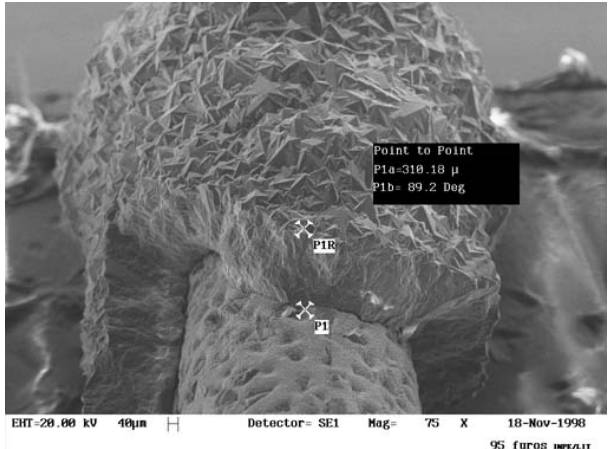
Figure 1. Broken chemical vapor deposition (CVD) diamond enhanced burr.